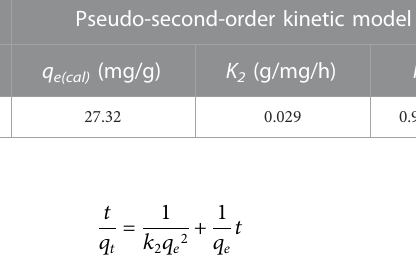
TABLE 4 Comparison of kinetic parameters of Pb (II) adsorption onto Mag-700. C 0